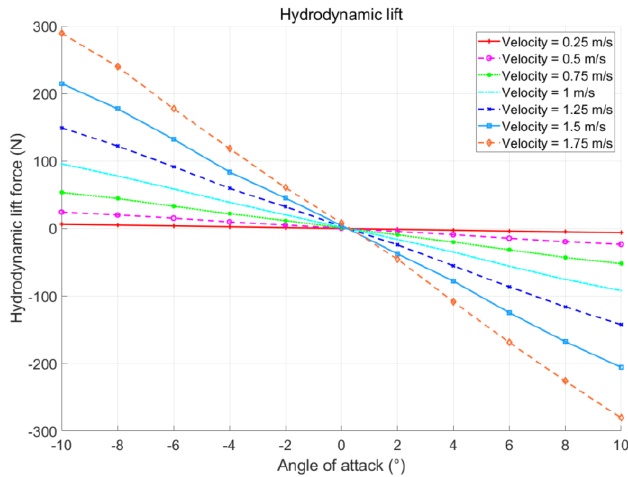
Figure 8. Hydrodynamic lift.